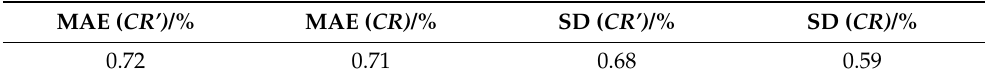
Table 6. Error analysis for all